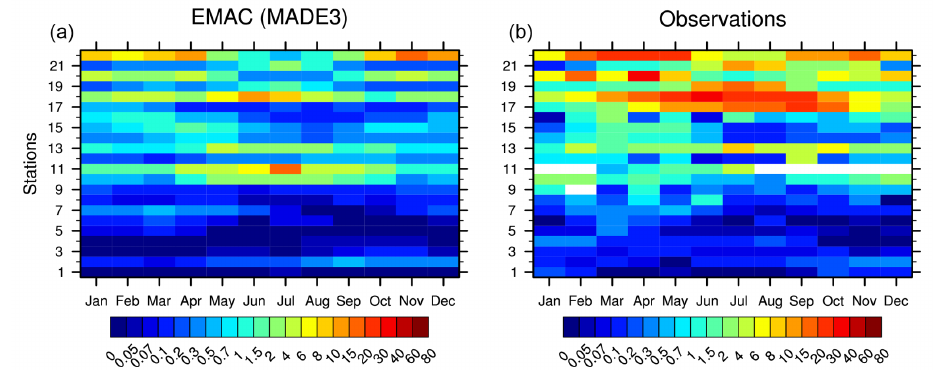
Figure 4. Climatological annual cycle of simulated (a) and measured (b) dust surface-level concentrations in units of µgm − 3 . The observa- tional data were collected by Huneeus et al. (2011). The locations of the 22 stations considered in the plot are shown in Fig. 6 of Aquila et al.